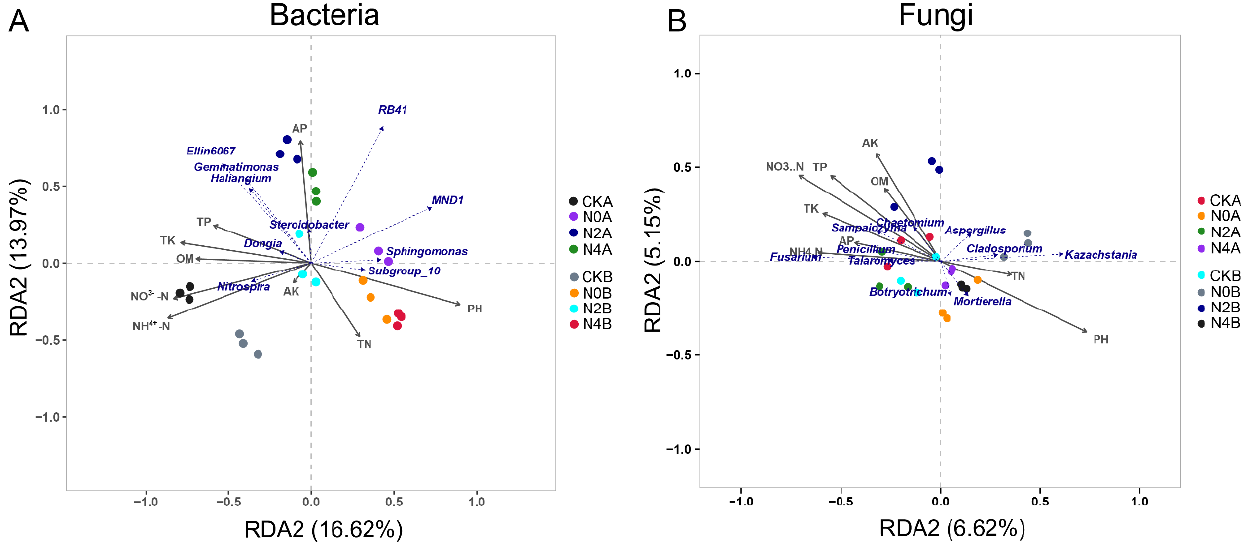
Figure 10. Redundancy analysis of bacteria and fungi. The significant difference quadrant is divided by gray dashed lines. Dots represent observed samples. Treatments are shown in different colors. Solid lines represent soil nutrients. The blue dashed lines represent the major differential microorgan- isms. The magnitude of the angle between the line segments and the points represents the positive, negative correlation and the level. ( A ) Bacteria. ( B )